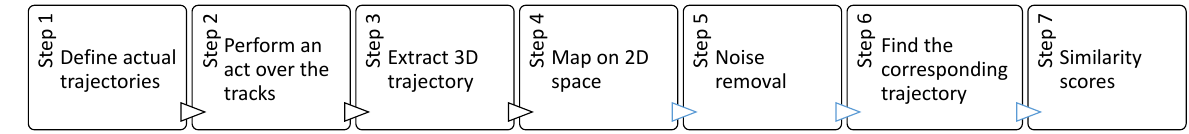
Figure 2. Trajectory assessment, using Kinect sensor, adopted